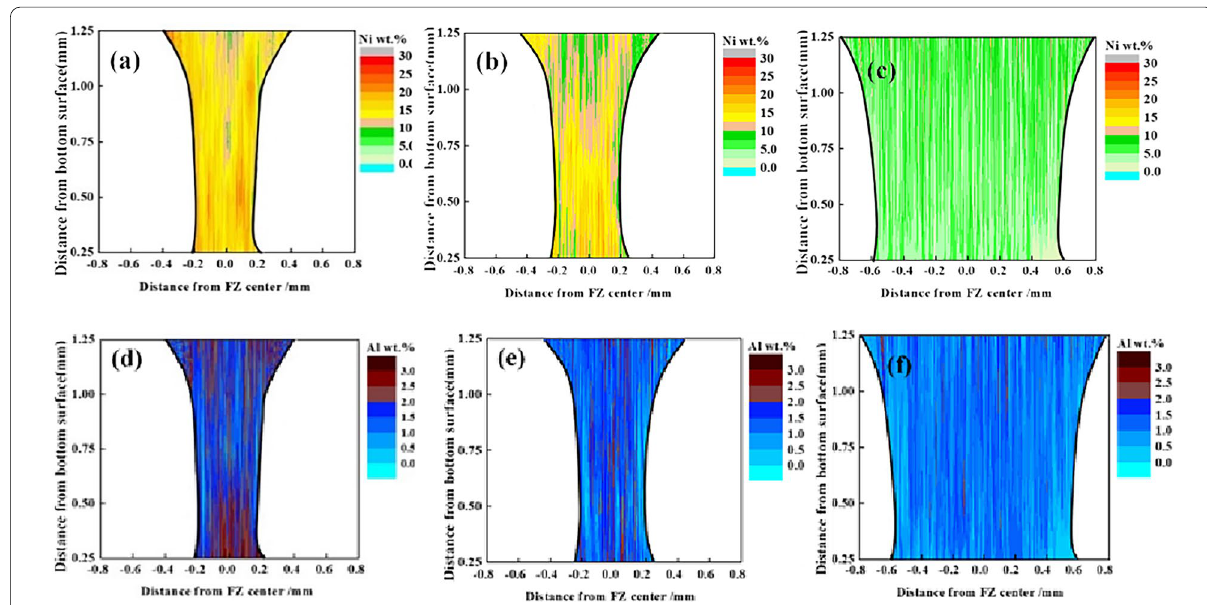
Figure 7 Elemental distribution in fusion zone with different oscillation amplitudes: a A osc A osc , Al, f A osc , Al = 0.5 = 1.3